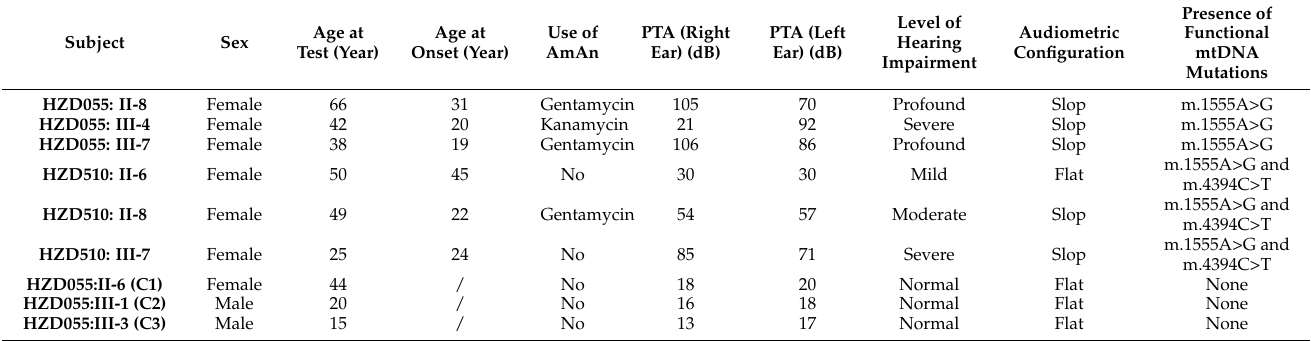
Table 2. Summary of the clinical data of several members in two pedigrees with hearing impairment.